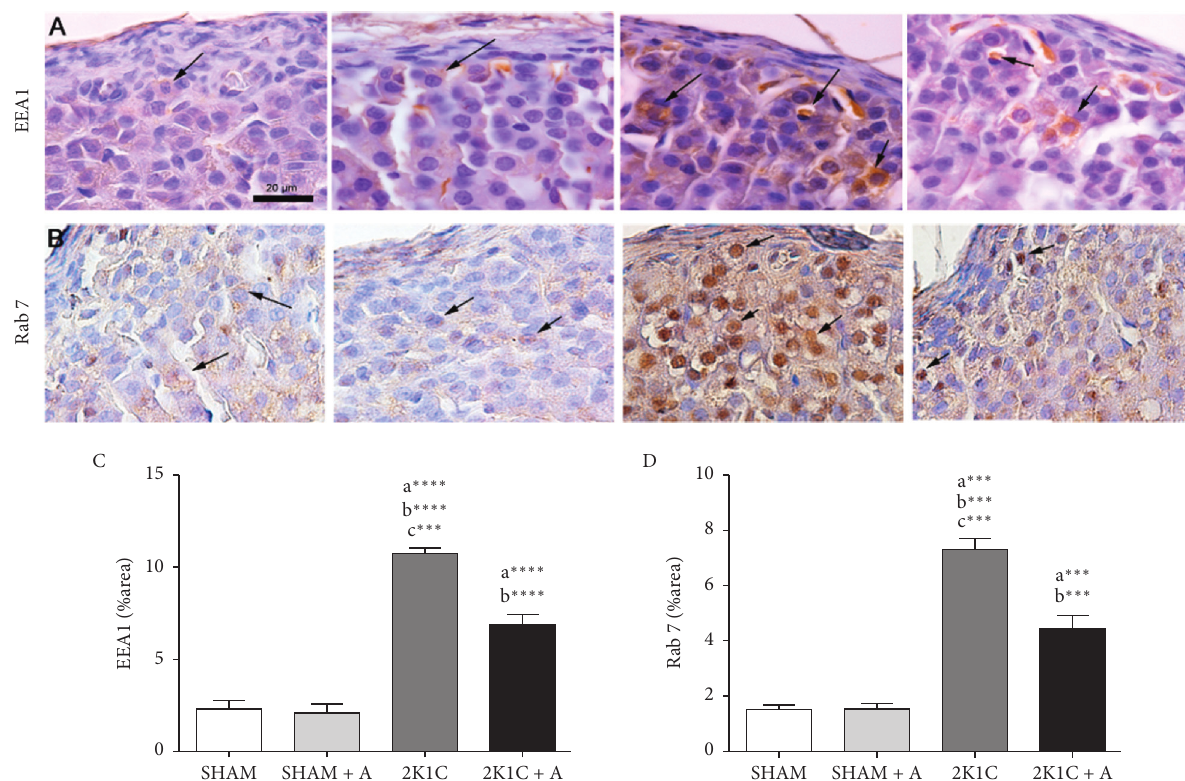
Figure 3: Detection and quantification of EEA1 and Rab 7 expression by immunostaining in the zona glomerulosa. (A)-(B), photo- micrographs of all experimental groups marked with anti-EEA1 and anti-Rab 7 antibodies, respectively (C)-(D), quantification of EEA1 and Rab 7, respectively. Arrows indicate the immunostained positive cells. (a) represents ≠ to the SHAM group, (b) represents ≠ to the SHAM +A group, and (c) represents ≠ to the 2K1C +A group. ∗∗∗∗ p < 0 . 0001; ∗∗∗ p < 0 . 001. n � 10 for all experimental